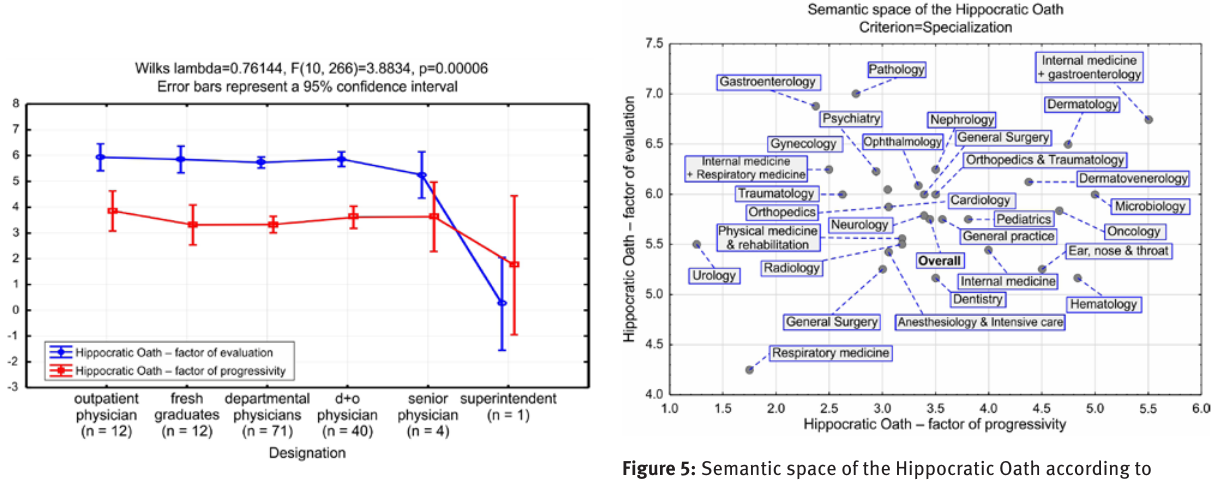
Figure 4: Line graph of factor distribution by designation